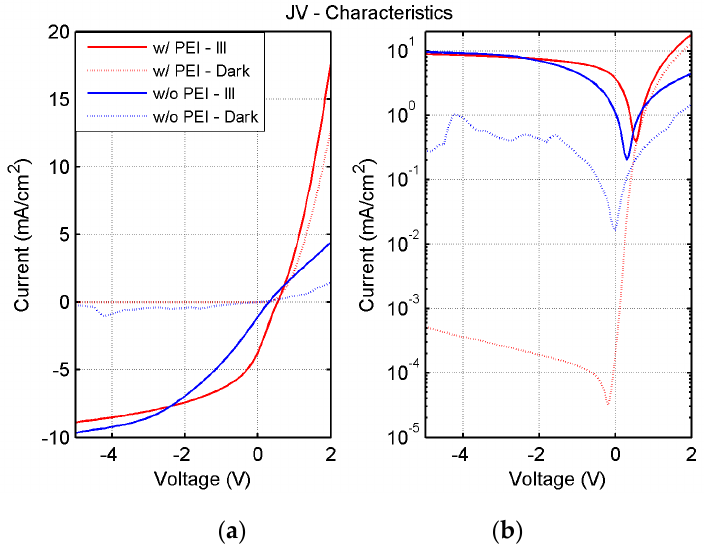
Figure 6. Dark (dashed lines) and illuminated (solid lines) JV characteristics, in linear ( a ) and logarithmic ( b ) scale, of the fully-sprayed organic photodiode with and without PEI. Current density as low as 5 × 10 − 4 mA/cm 2 have been reliably achieved.